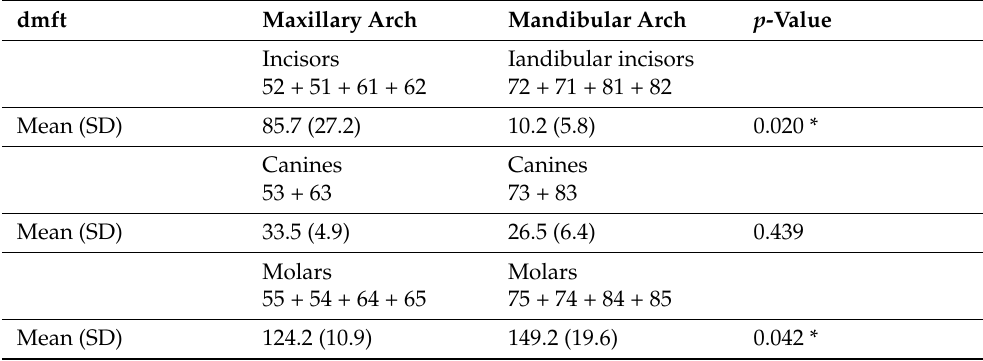
Table 5. Comparison of tooth-based dmft mean scores based on arch